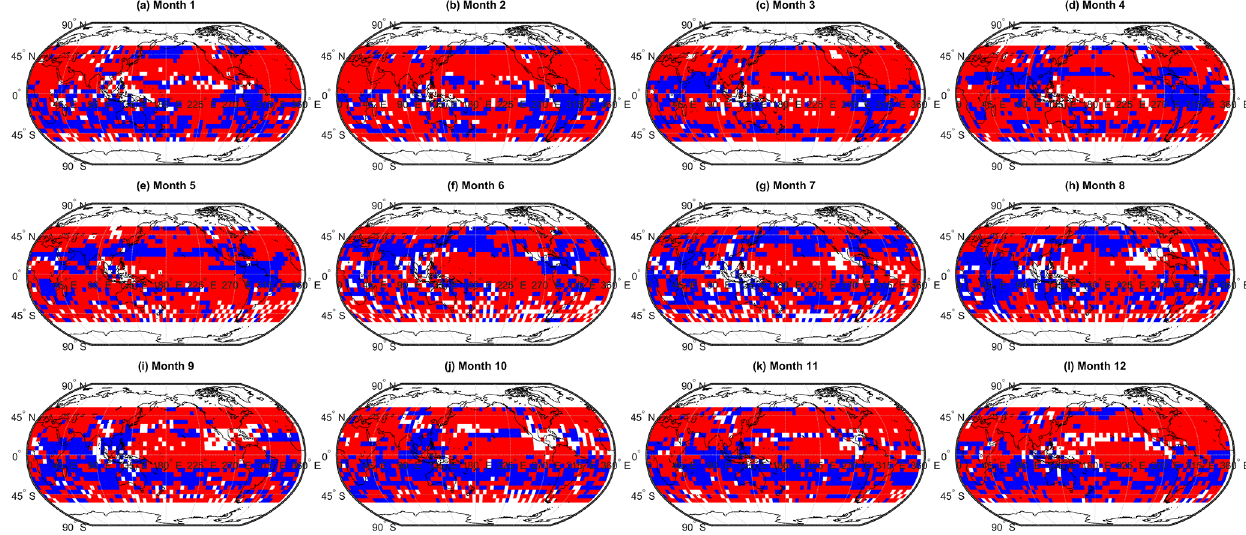
Figure 8. As Fig. 7 but showing a binary of grid cells in which the model–observation bias has reduced (red), increased (blue), or not changed (white) as a result of the cluster-based ensemble subsampling.